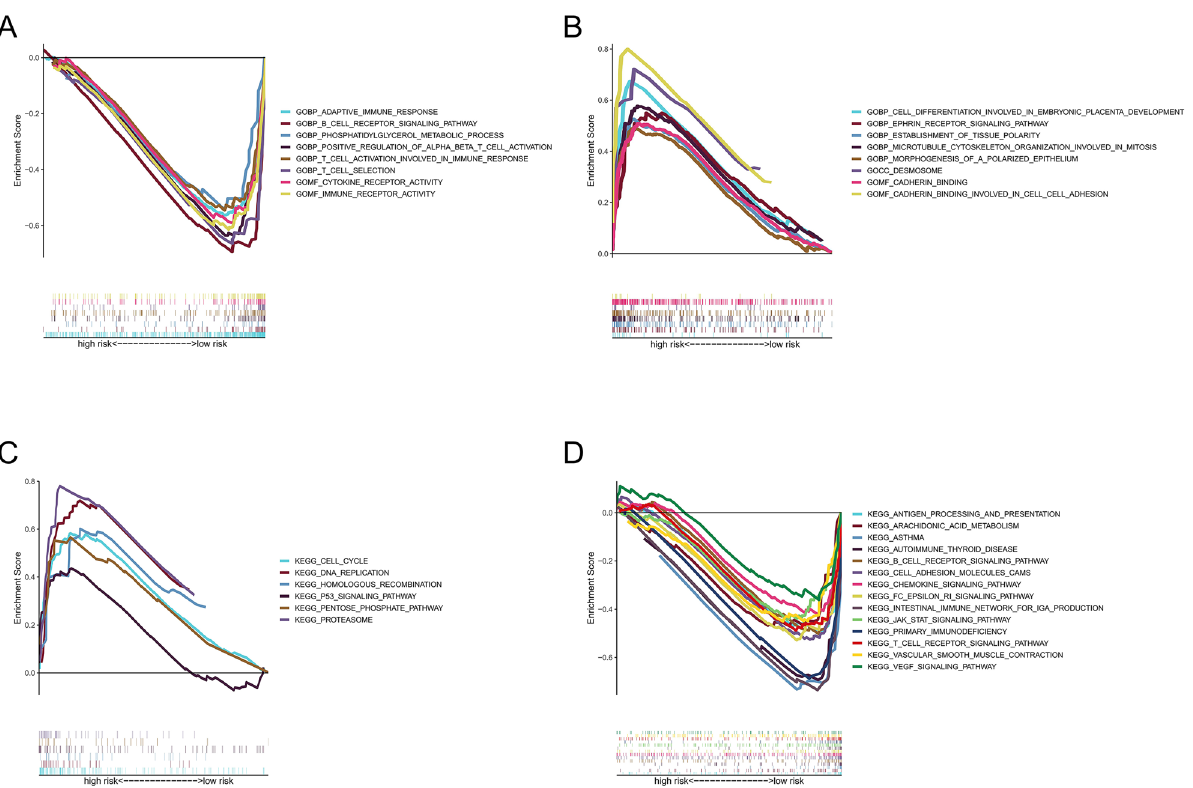
Figure 5. Gene Set Enrichment Analysis of the mRNAs associated with the high or low risk group in TCGA using GSEA software. ( A ) Top enriched GO functions in the low-risk group. ( B ) Top enriched GO functions in the high-risk group. ( C ) Top enriched KEGG pathways in the high-risk group. ( D ) Top enriched KEGG pathways in the low-risk group. The names of enriched KEGG pathways or GO functions are listed on the right side ( p -value <